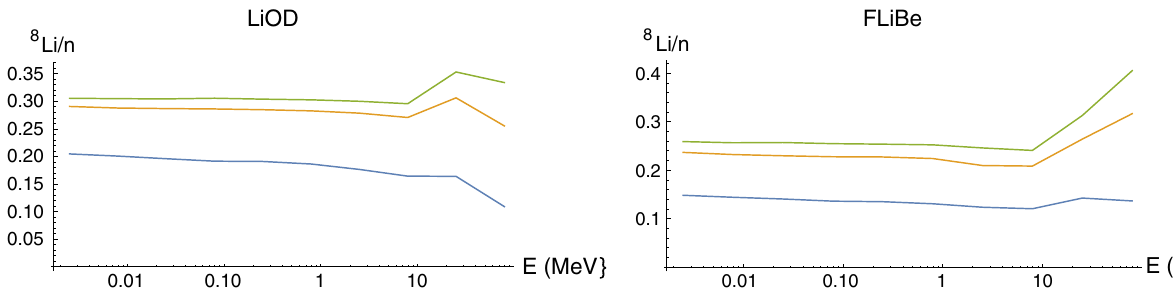
asymptotic value agrees well with p ν calculated in Eq.